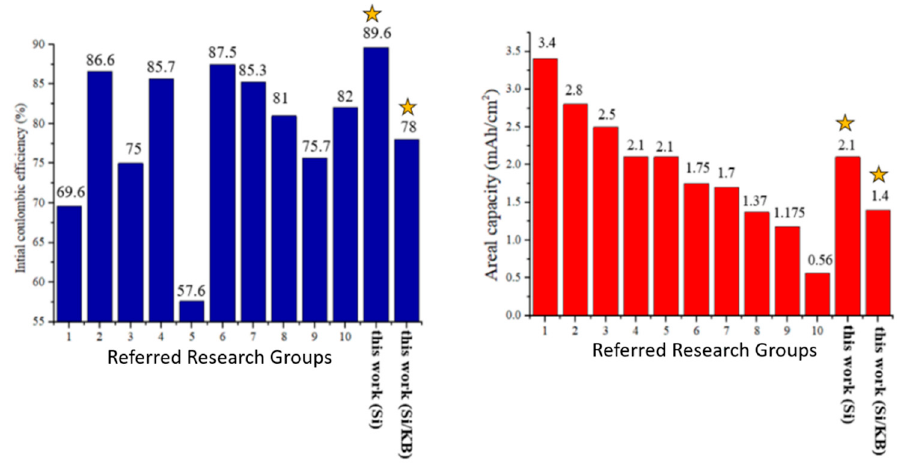
Figure 15. Comparison of initial coulombic efficiency (blue bars) and areal capacity (red bars) of selected high-performance anodes reported in the literature. Referred research group #1 is [25] and group #2 is [26] and so on. Bars for this work are marked by yellow stars.